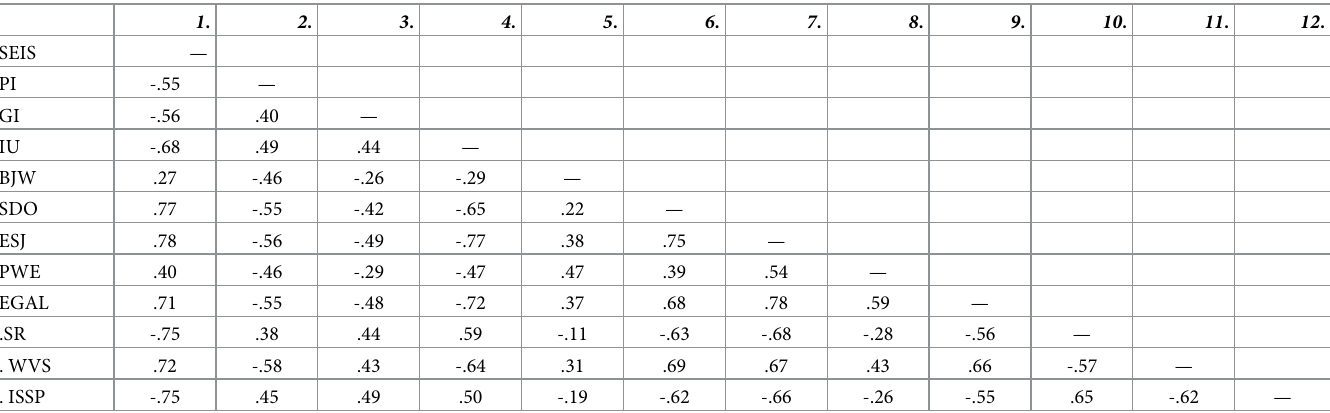
Table 6. Correlations between all predictor variables in Study 5.